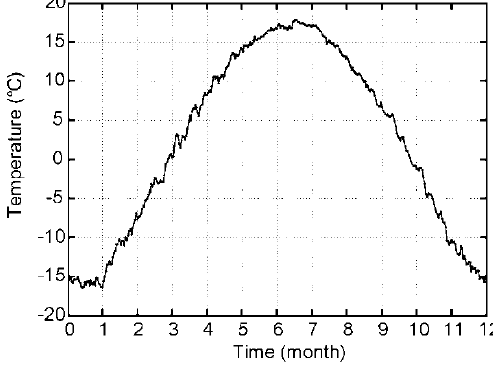
Figure 2. Yearly variation in external air temperature of Ningwu ice